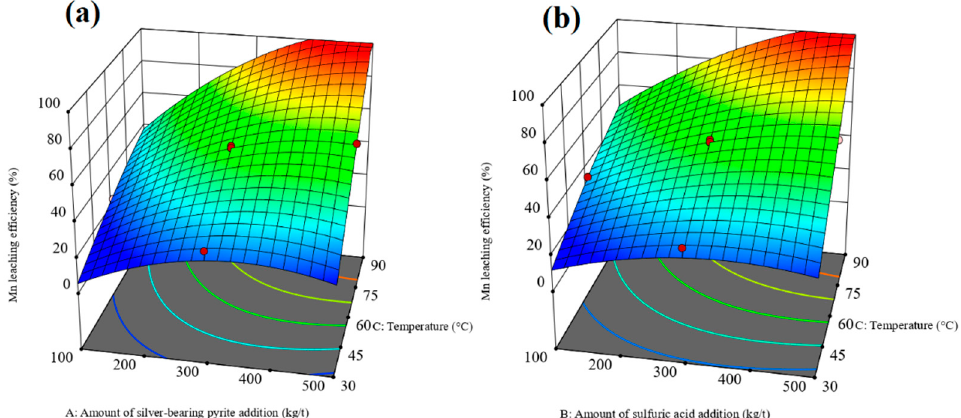
Figure 4. Contour and 3D response surface plots for Mn leaching efficiency ( a ); interaction plots of amount of silver-bearing pyrite addition and temperature on Mn leaching efficiency; ( b ) interaction plots of amount of sulfuric acid addition and temperature on Mn leaching efficiency.